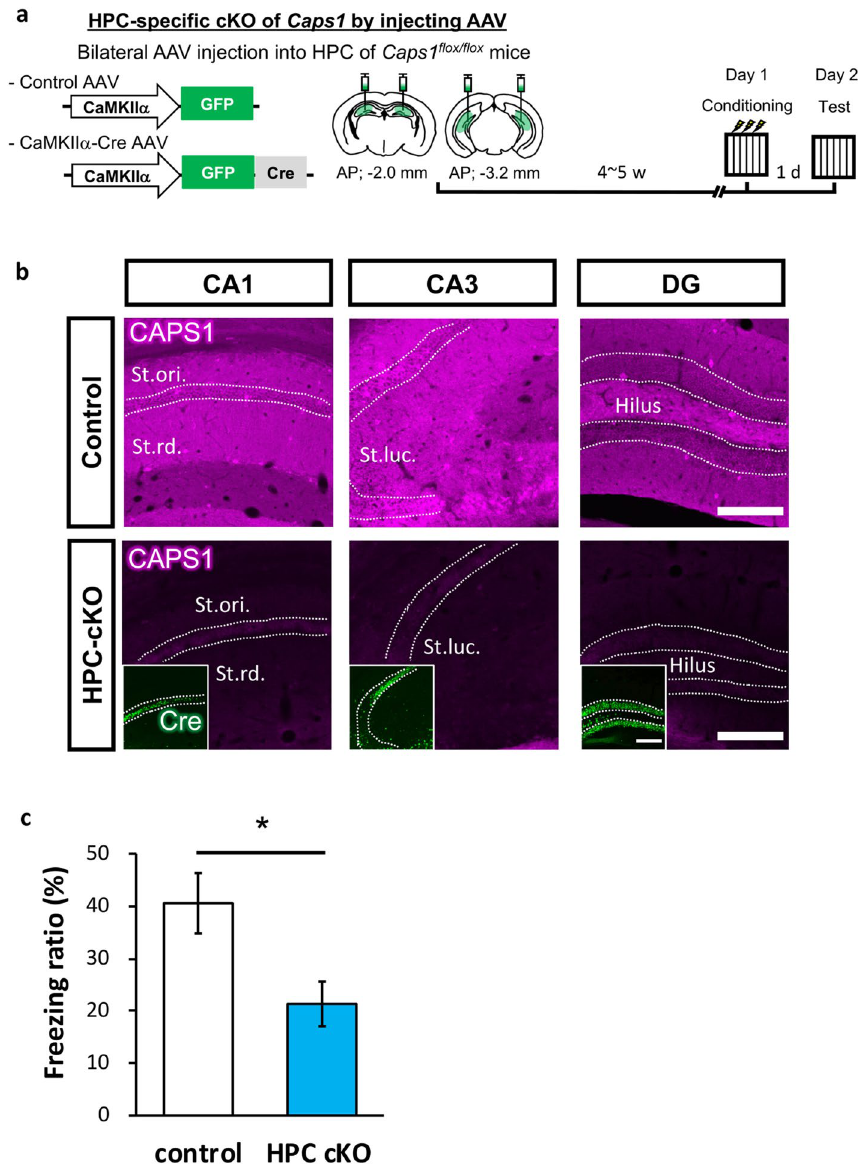
Figure 7. Memory deficits in adult mice with hippocampus-specific Caps1 cKO. ( a ) The experimental scheme used for the knockout of Caps1 in the adult hippocampus (HPC-cKO) and for testing CFC memory formation. ( b ) Representative images of immunohistochemical staining of CAPS1 in AAV-injected mice. The expression levels of the CAPS1 protein were sufficiently reduced in the hippocampus of HPC-cKO mice. The insets in the images of HPC-cKO slices show the expression of the Cre protein in the hippocampus. Scale bars, 200 µm. St.rd.: Stratum radiatum, St.ori.: Stratum oriens, St.luc: Stratum lucidum. ( c ) Mean freezing ratio during the CFC-LTM retrieval test. Control: n = 6 animals; HPC-cKO: n = 8 animals. P = 0.018, Student’s t